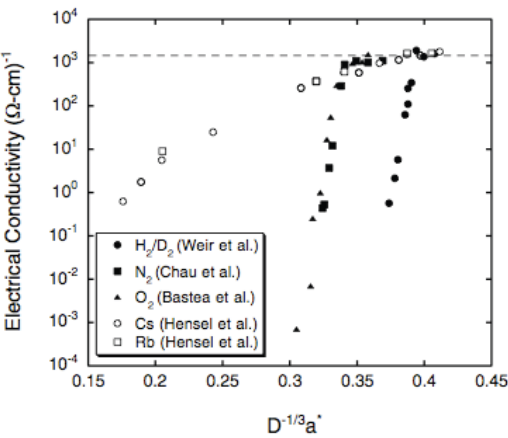
is size of atom (effective Bohr radius) and D is volume of average cube around each atom.